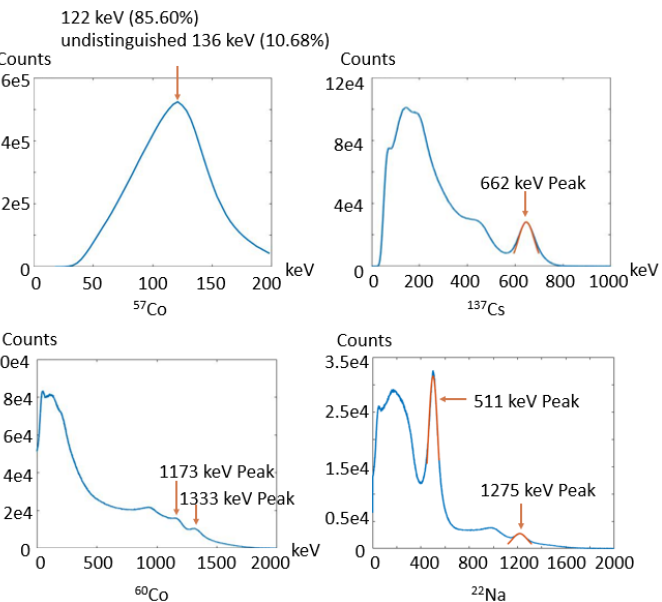
Figure 7. Energy spectrum in detector calibration (the blue line is the measured data and the red line is the Gaussian fitting of the energy peak).